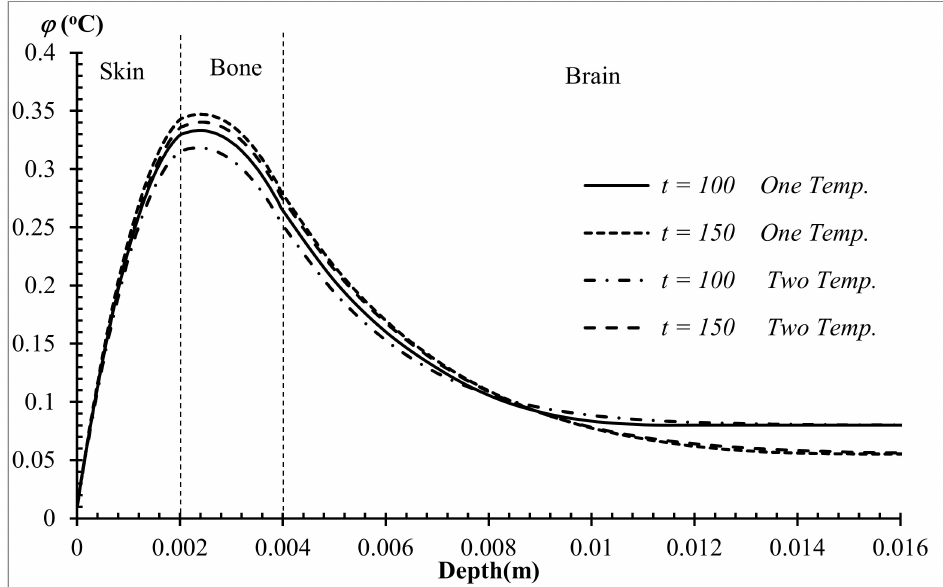
Figure 11. The conductive temperature increment at various times on a child’s head. Figures 12–19 represent the dynamical temperature increment distributions with various values of power transmission A = ( 100 , 1800 ) MHz, the power density I o = = 0 s and τ (cid:54) = 0 s, and time t = ( 100 , 150 ) s, for ( 100 , 600 ) mW/cm 2 , relaxation times τ i i adult and child heads, respectively. Those figures confirmed that all the parameters men- tioned above had significant effects on the dynamical temperature increment